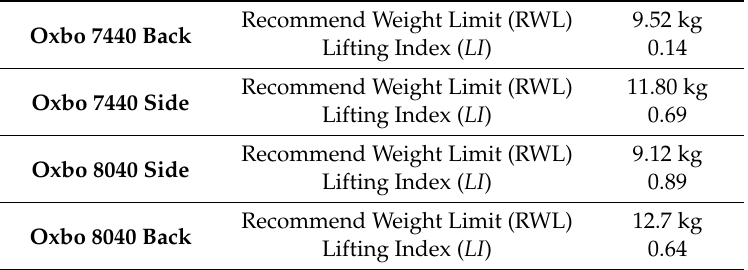
Figure 10. Example lifting postures: ( A ) Oxbo 7240 Back, ( B ) Oxbo 7440 Side, ( C ) Oxbo 8040 Side, and ( D ) Oxbo 8040 Back. Table 7. National Institute for Occupational Safety and Health (NIOSH) lifting equation results for lifting task during over-the-row (OTR) harvesting.